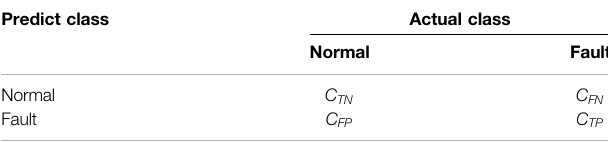
TABLE 1 | Cost matrix of two classi fi cation problems. Predict